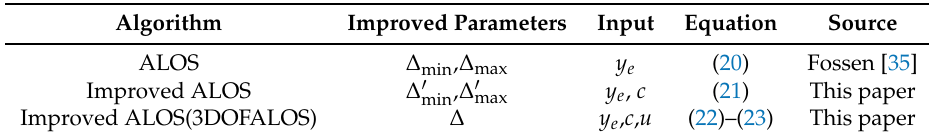
Table 2. ALOS algorithm